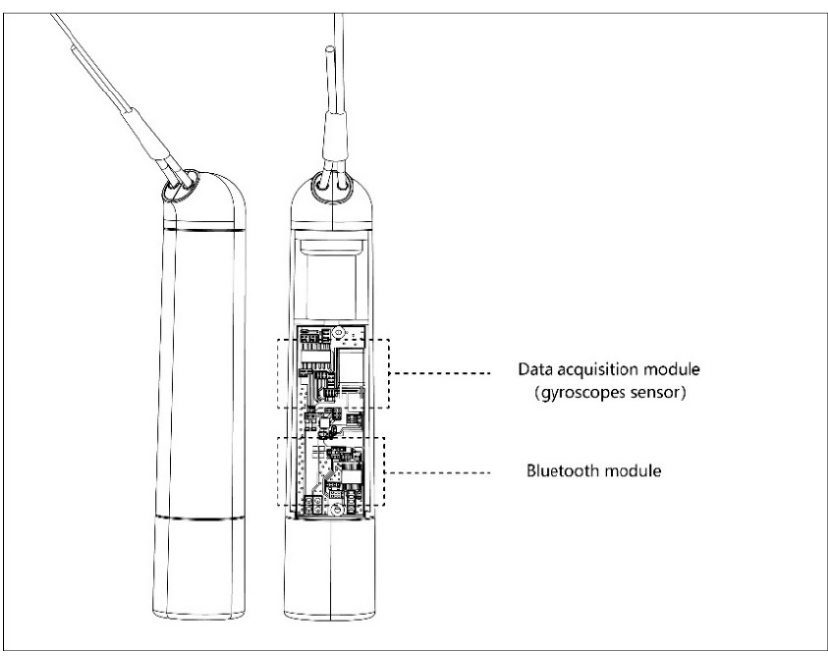
Figure 5. Internal structure of the intelligent skipping rope.